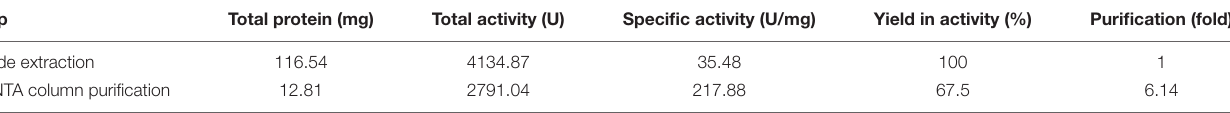
TABLE 4 | The purification of Ps-Grx3.